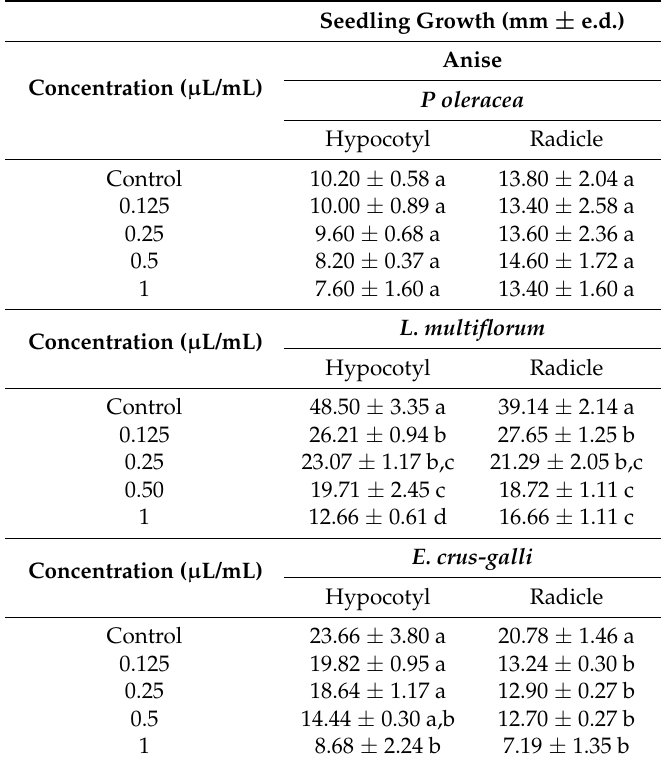
Values are mean of five replications ± error deviation after 14 days of incubation. Means followed by different letters in the same column indicate that they are significantly different at p > 0.05 according to T3 Dunnet and Tukey